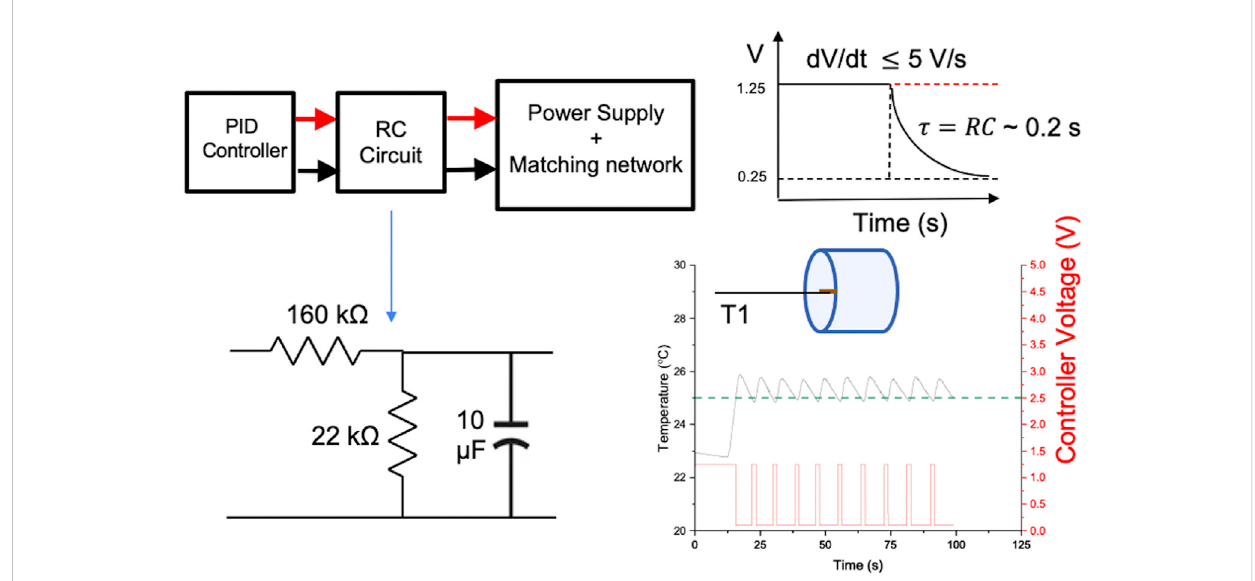
FIGURE 5 Safety and reliability of the temperature controller. Schematic of RC circuit designed to smooth sharp transitions in voltage. Sharp transitions can induce undesirable power system harmonics that can be damaging to the electronics, or cause power faults. An upper limit to the acceptable rate of change of voltage, dV/dt, was identi fi ed as 5 V/s. An RC circuit with a time constant of 0.2 s was suf fi cient to maintain dV/dt < 5 V/s, for speci fi ed upper and lower limits of power supply used for PID